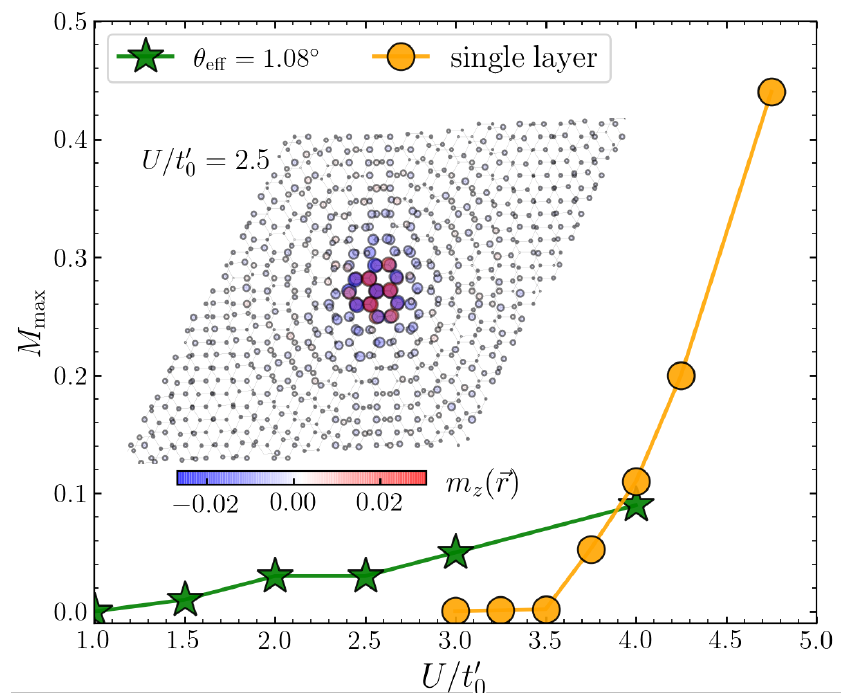
Figure 4: DMFT results for the magnetization versus Hubbard interaction U / t (cid:48) = 1.08 ◦ . For comparison, results for a single graphene the rescaled system with θ eff layer are also shown. Lines are guides to the eye. The inset shows the spatial mag- = netization for U / t (cid:48) 0